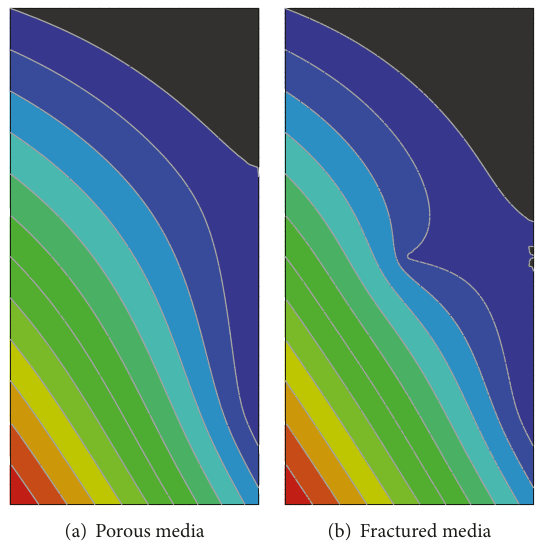
Figure 11: Pore pressure fields obtained by ABAQUS-PPCE.